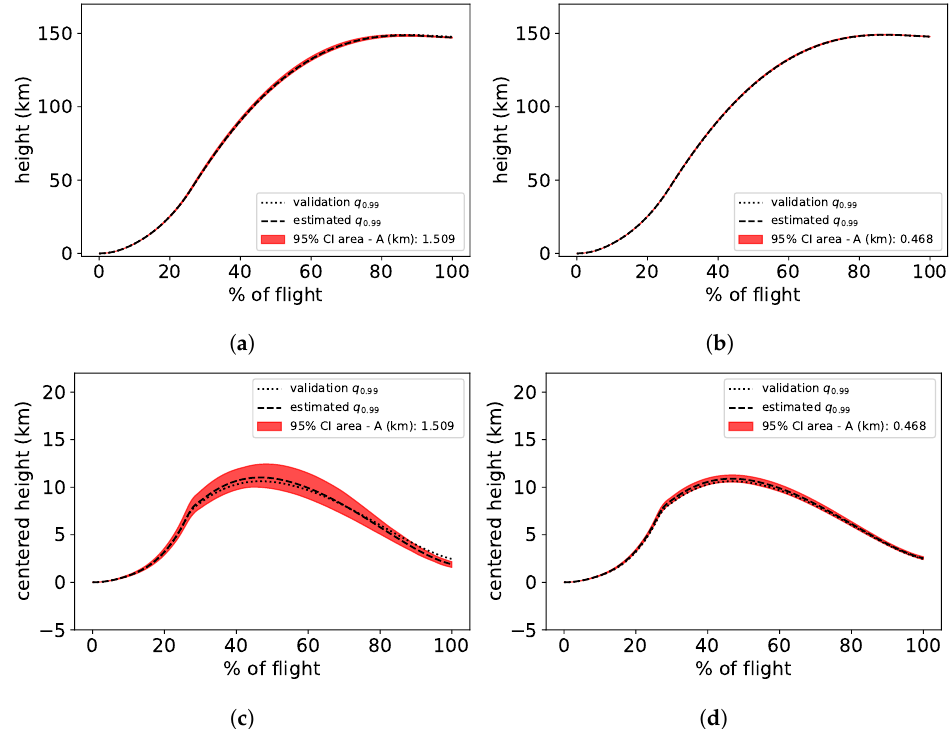
Figure 18. Quantile estimation and confidence area with initial dataset ( a , c ) and after 10 active- learning-based enriched samples ( b , d